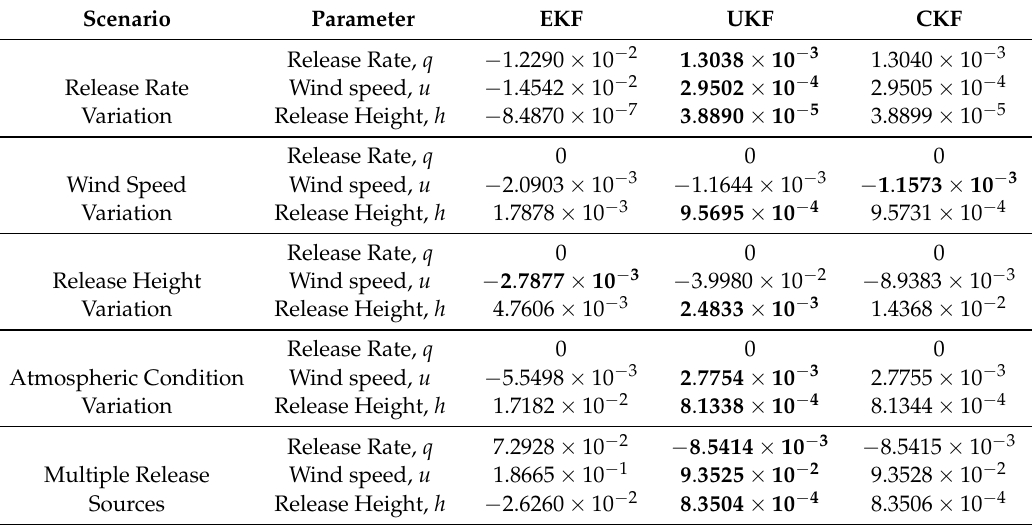
Table 3. Fractional Bias between true and estimated states for EKF, UKF, and